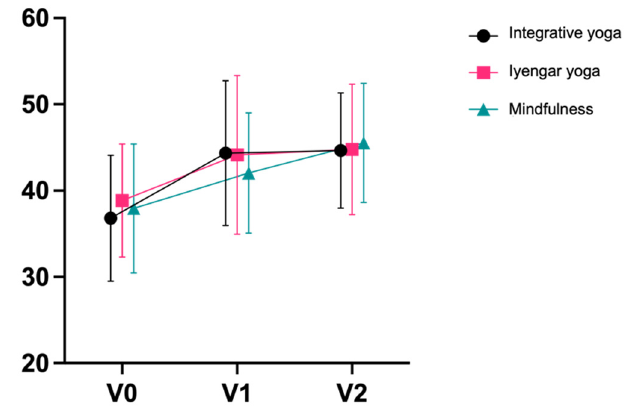
Figure 5. Mental Component—Quality of Life SF-36 (Mean ± SD).